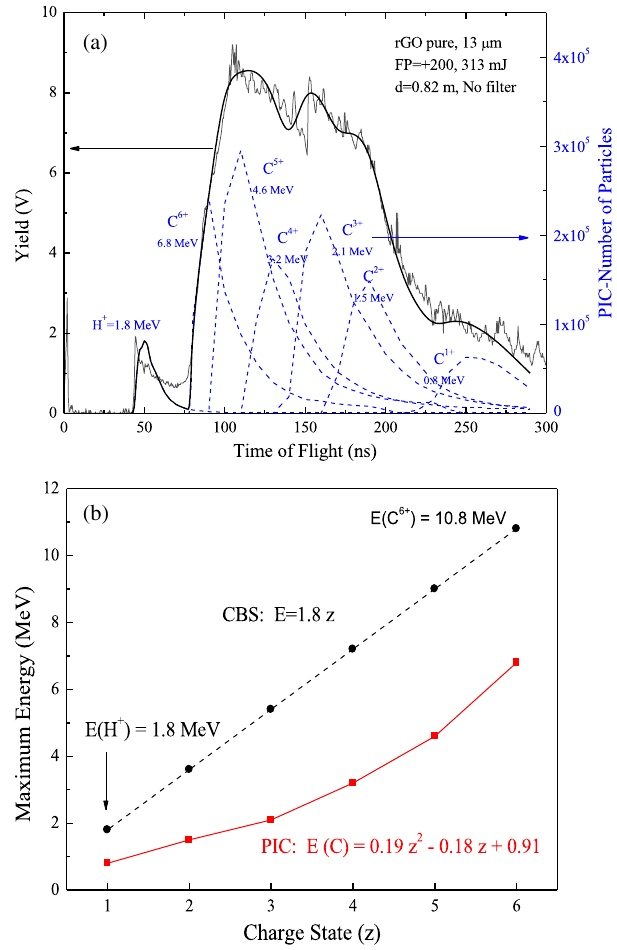
FIG. 6. SiC-TOF spectrum and deconvolution peaks of protons and carbon ions, with their maximum energy, as evaluated from PIC code (a) and maximum ion energy versus charge state calculated by PIC and using the CBS approach